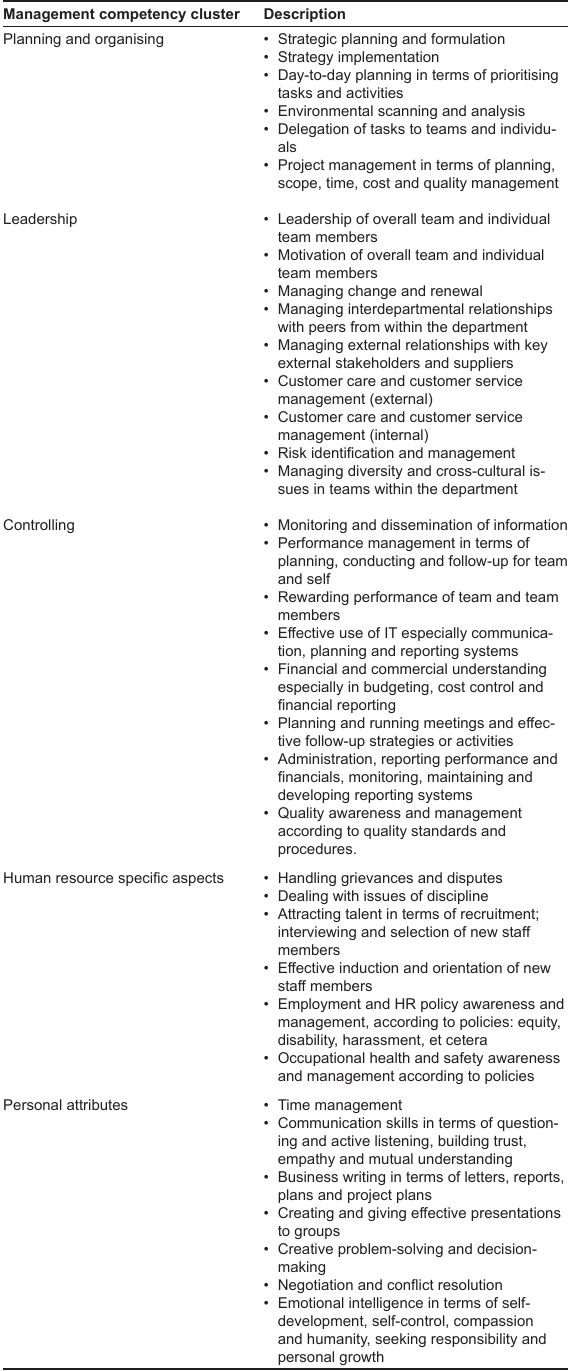
TABLE 1 Overview of head of department management competency